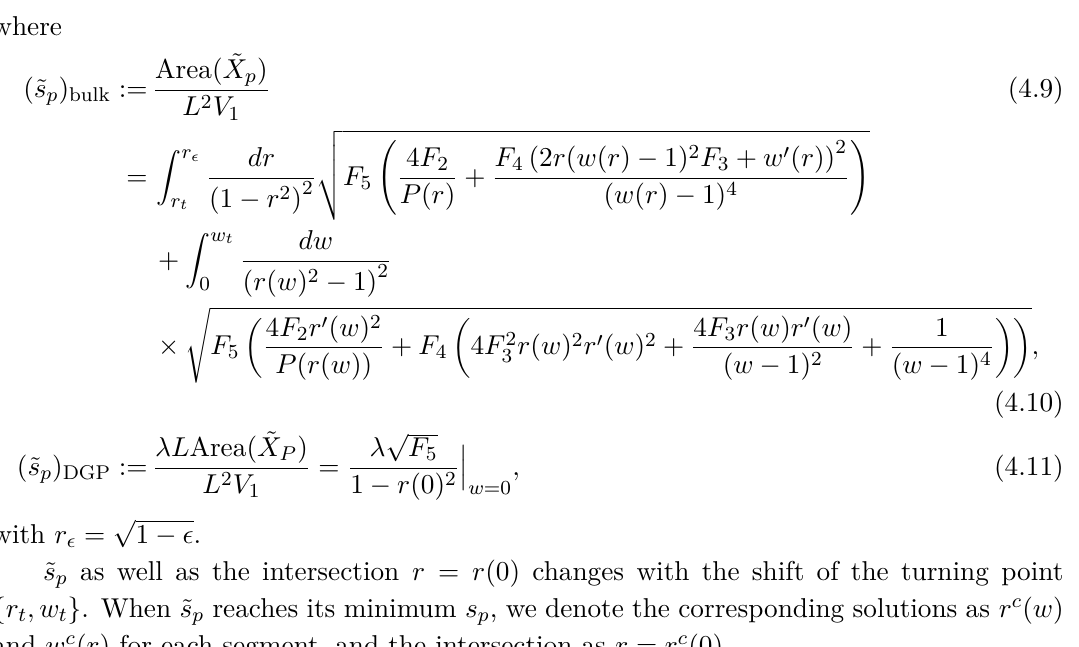
Figure 6 . In the first row, three components of the induced metric on the brane, h tt , h rr and h yy , are depicted respectively in coordinates ( t, w, r, y ) . All the components are multiplied by a factor (1 − r 2 ) 2 . While in the second row, three components of the induced metric on the brane, h L 2 h zz and h yy , are depicted in different coordinates ( t, z, x, y ) . All the components are multiplied by a factor z 2 . Here L is fixed to be 1 and the curves from violet to red are plotted with different L 2 λ = 0 . 3 , 0 . 4 , 0 . 5 , 0 . 6 , 0 . 7 , 0 . 8 , 0 . 9 , 1 , 1 . 6 , 2 , 7 , 14 , 28